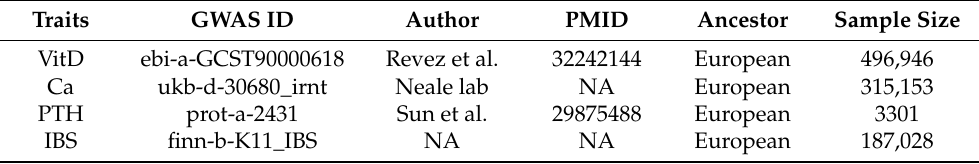
Table 1. The information of datasets used in our